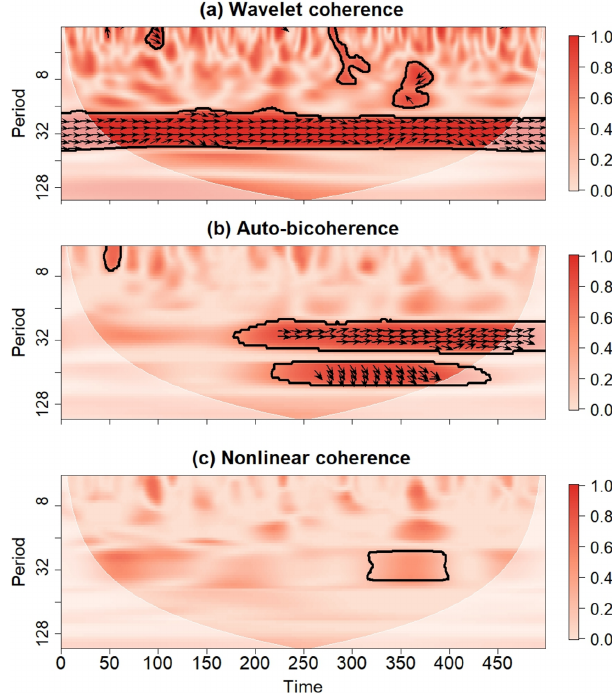
Figure 2. (a) Wavelet coherence between the time series of F(t) and R(t) as shown in Fig. 1. Arrows indicate the relative phase differ- ence, where arrows pointing to the right mean that the time series are in phase. (b) The local diagonal slice of the auto-bicoherence spectrum of F(t) . Arrows represent the biphase, where arrows pointing to the right mean that the quadratic-phase coupling be- tween the mode with period indicated on the vertical axis and its harmonic contributes to positive skewness. (c) Nonlinear coherence between F(t) and R(t) . Contours in all panels enclose regions of 5% cumulative area-wise significance. The shaded region repre- sents the cone of influence where edge effects may be